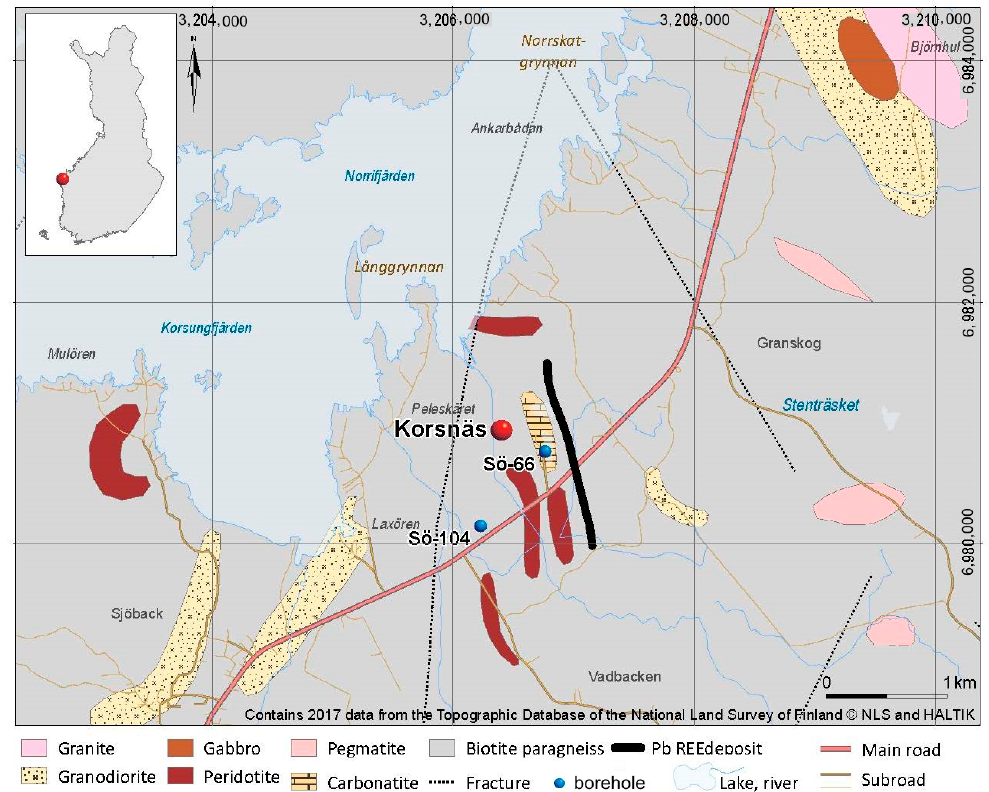
Figure 4. Geological map of the bedrock in the Korsnäs area according to the electronic DigiKp map sheet of the Geological Survey of Finland. Coordinates correspond to Finnish National Coordinate System ETRS-TM35FIN.